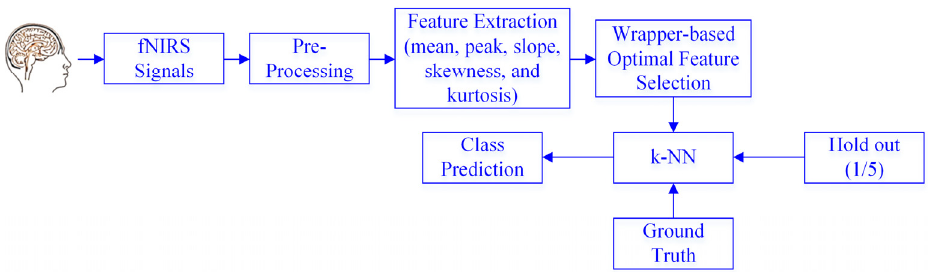
Figure 1. Proposed wrapper-based feature selection approach for the functional near-infrared spec- troscopy (fNIRS)